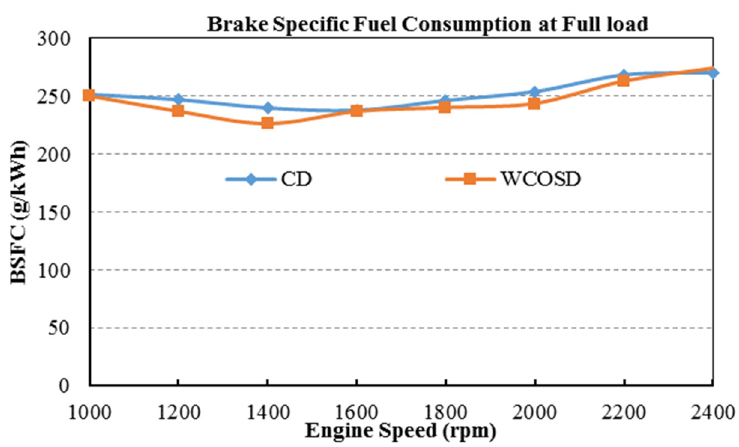
Figure 3. The BSFC at full load condition. Figure 2. The BSFC at full load